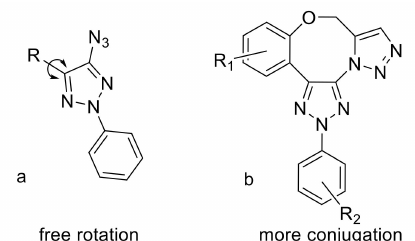
Figure 3. Structures of studied heterocycles. ( a) 4-azido-1,2,3-triazoles having free rotation of substituent in the position 5. ( b ) rigidified derivatives having restricted rotation.